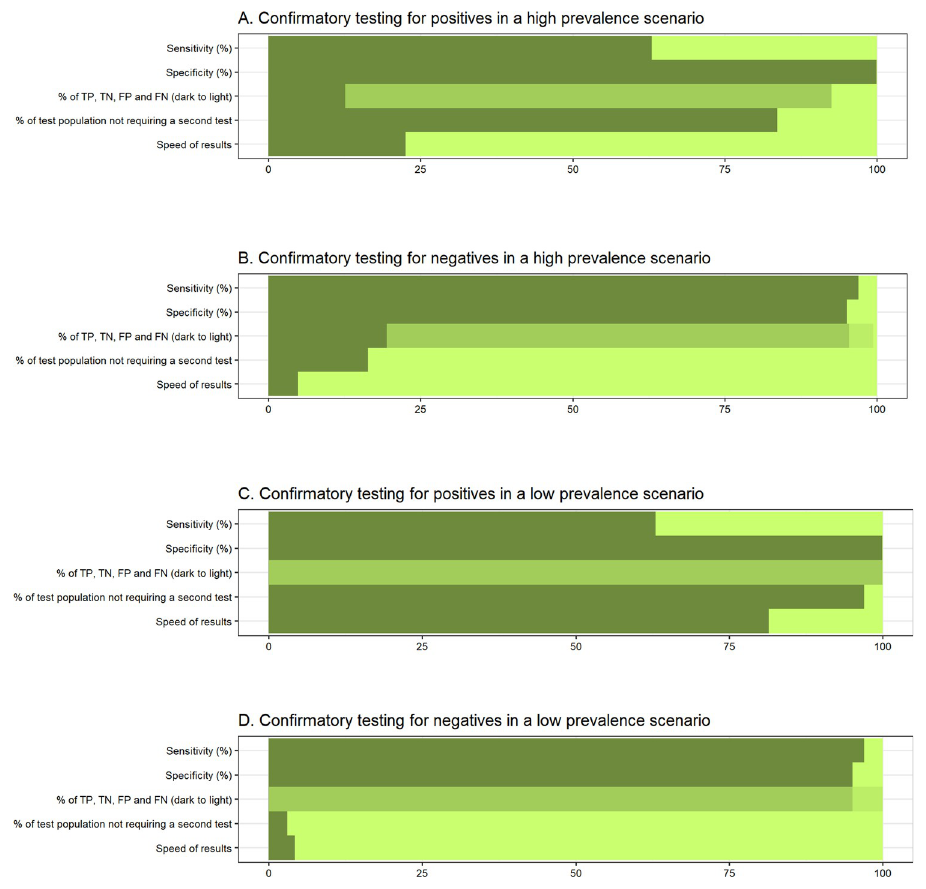
Fig 6. Bar diagrams showing the assessment of test algorithms in various scenarios. A. Confirmatory testing for positives in a high prevalence scenario. B. Confirmatory testing for negatives in a high prevalence scenario. C. Confirmatory testing for positives in a low prevalence scenario. D. Confirmatory testing for negatives in a low prevalence scenario. Interpretation: the darker the graph, the better the algorithm; TP = true positive, TN = true negative, FP = false positive, FN = false negative; the percentage of the test population who do not require a second test is a proxy for the cost-effectiveness of the algorithm; speed of results = number of tests per 100 people per hour i.e., 100/average time to